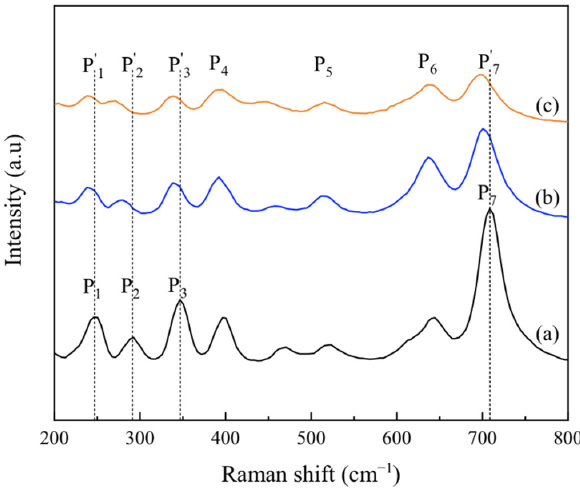
Figure 3. Raman spectra of products after calcination at 800 °C for samples with different Co/Ni ratios: ( a ) 0.1:0.9, ( b ) 0.5:0.5, ( c ) 0.9:0.1. ratios: ( a ) 0.1:0.9, ( b ) 0.5:0.5, ( c )